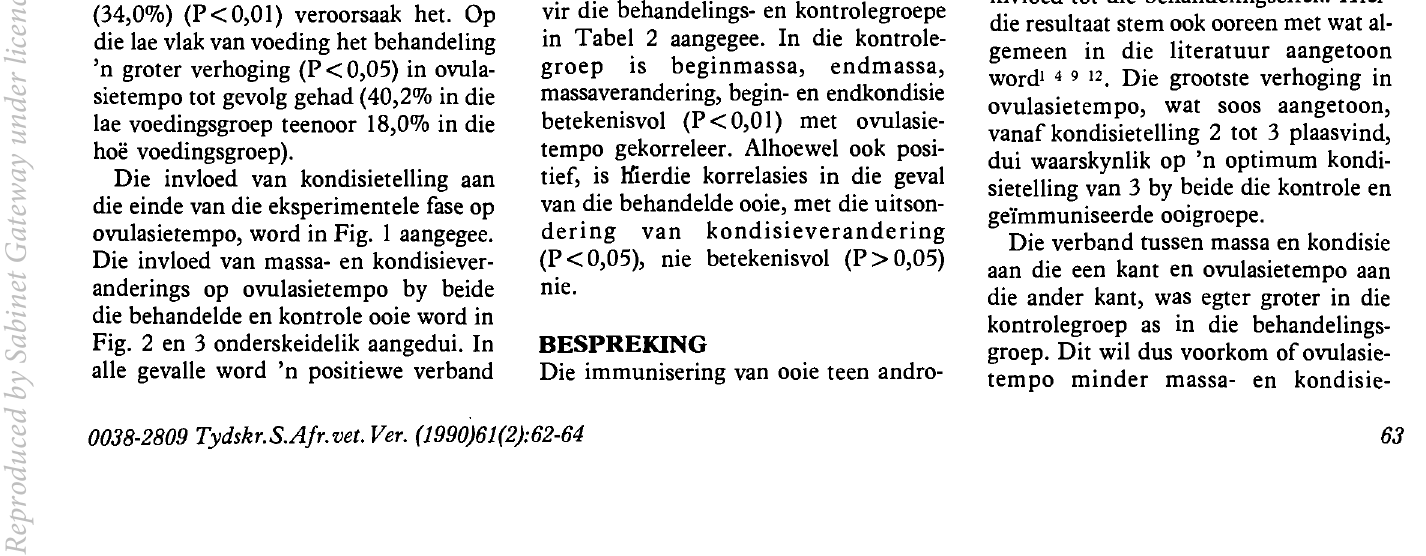
delik. Enkelvoudige korrelasiekoeffisiente tussen ovulasietempo en massa, kondisie en massa- en kondisieverandering word